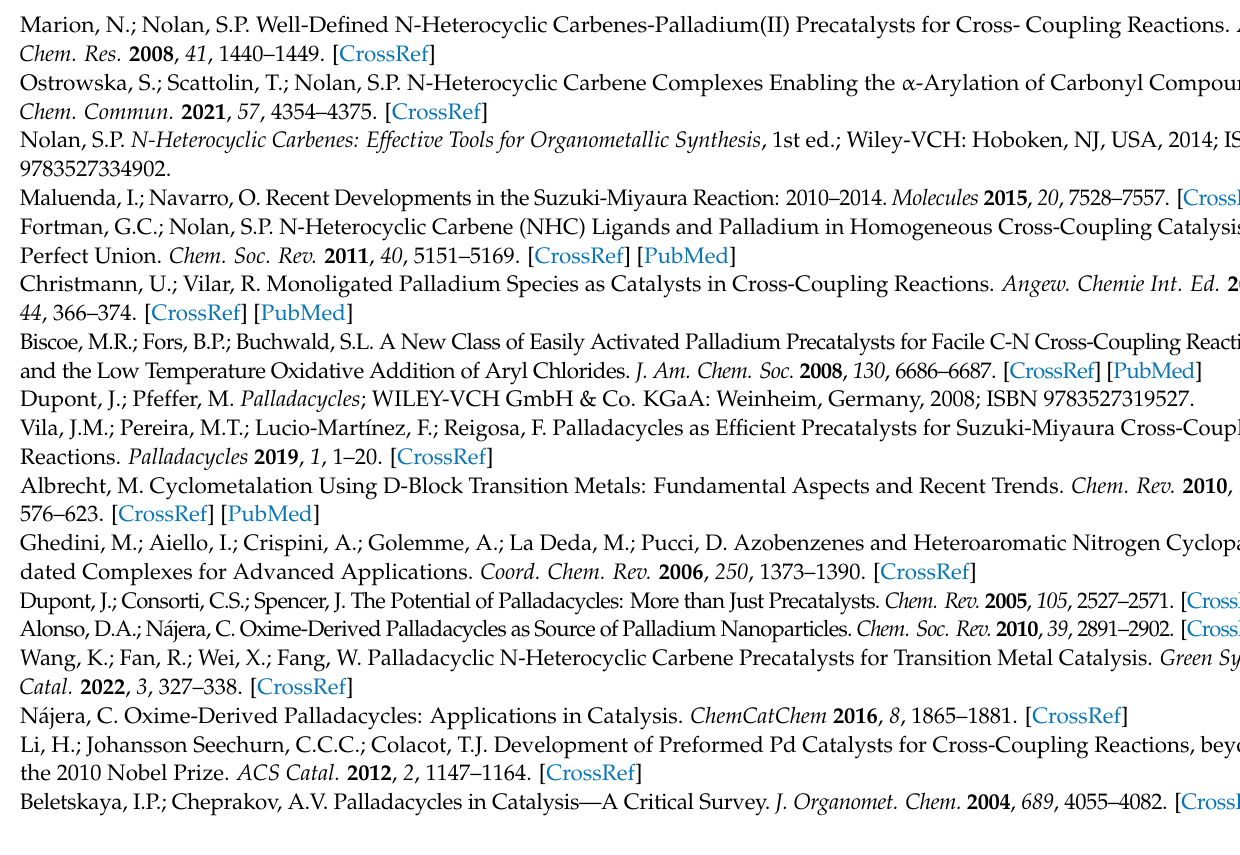
Table S4: Selected crystal data and structure refinement details ( 8 ); Table S5: Selected